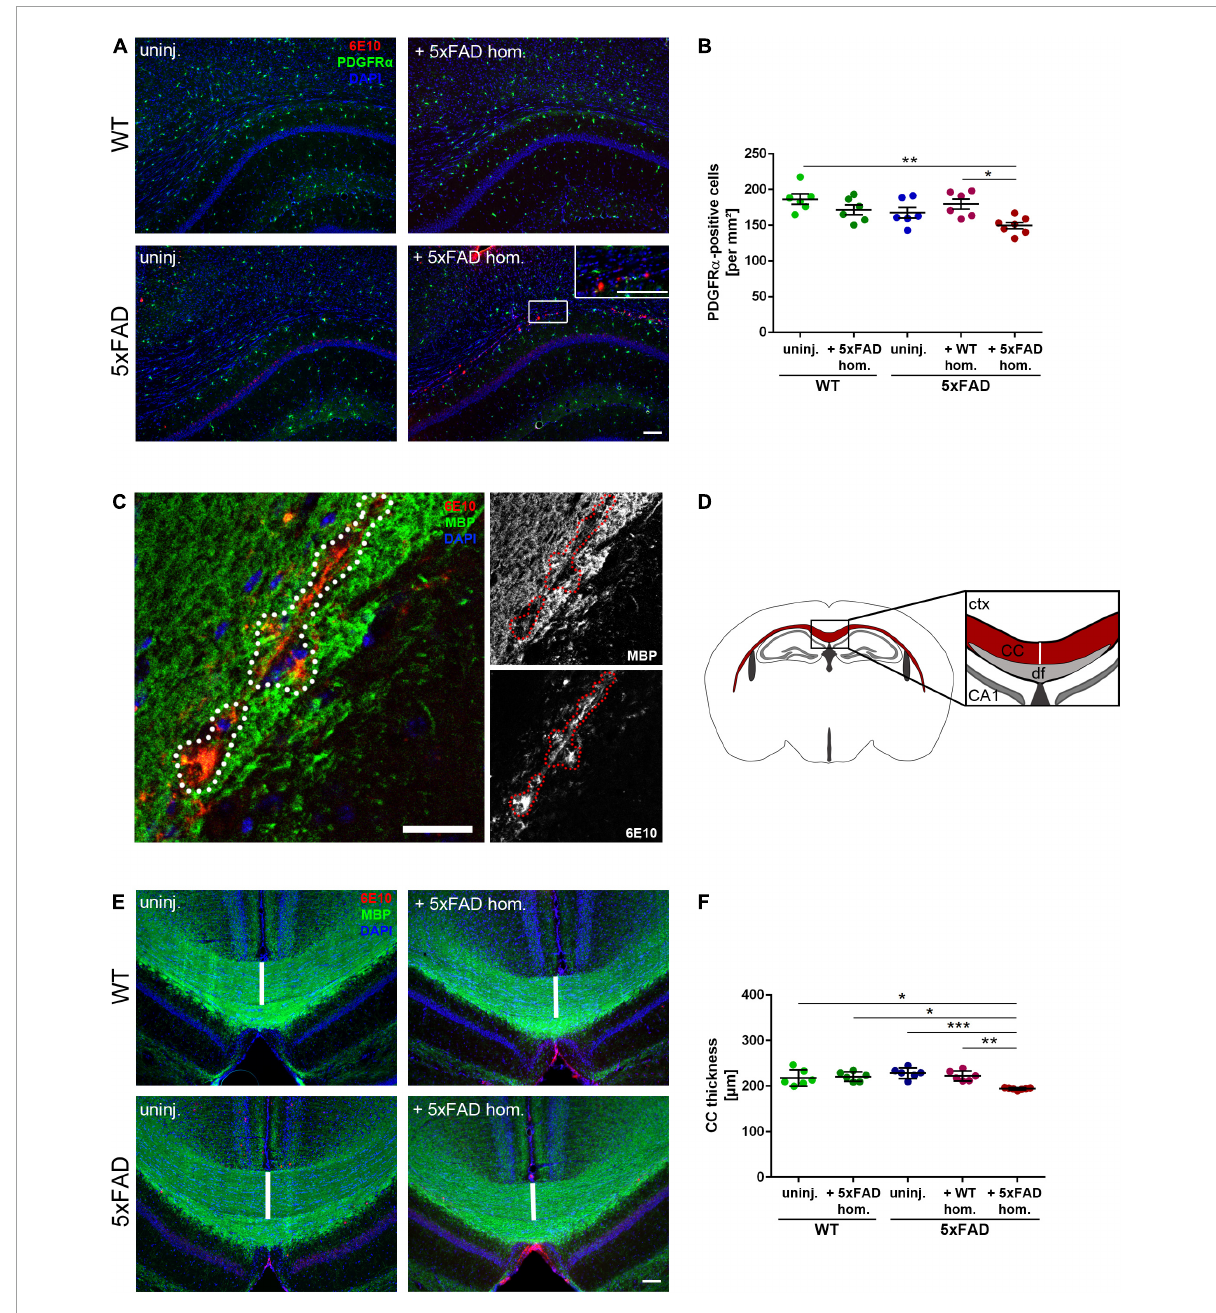
FIGURE4 Reduced oligodendrocyte progenitor cell (OPC) number and disrupted white matter integrity in the corpus callosum (CC) exhibiting amyloid-beta peptide (A β ) deposits. (A) Representative immunofluorescent staining of PDGFR α (green) and A β (red) of 4-month-old WT and 5xFAD mice, which were either uninjected or injected with 5xFAD brain homogenate. Scale bar for overview and inset 100 µ m. (B) Respective analysis of PDGFR α -positive cells in the CC. n = 6–7 mice analyzing n = 4–5 sections per animal. Each symbol represents data from one mouse. Mean ± SEM, Kruskal–Wallis test followed by Dunn’s multiple comparison test, * p < 0.05, ** p < 0.01. (C) Confocal microscopy of MBP (green) and A β (red) of 4-month-old 5xFAD mouse injected with 5xFAD brain homogenate. Dashed line indicates focal absence of MBP signal, which co-localizes with A β . Scale bar 30 µ m. (D) Graphic representation of the region of interest (indicated as a white line) in the CC (red) used to quantify the CC thickness. Abbreviations: Ctx, cortex; CA1, hippocampal CA1 region; df, dorsal fornix; CC, corpus callosum. (E) Fluorescence microscopy visualizing MBP (green) and A β (red) of 4-month-old WT and 5xFAD mice, which were either uninjected or injected with 5xFAD brain homogenate. Scale bar 100 µ m. (F) Respective quantification of the CC thickness. n = 6–7 mice with n = 3–5 sections analyzed per animal. Each symbol represents data from one animal. Mean ± SEM, Kruskal–Wallis test followed by Dunn’s multiple comparison test was used, comparing the A β seeded animals to the other 5xFAD groups. * p < 0.05, ** p < 0.01, *** p <